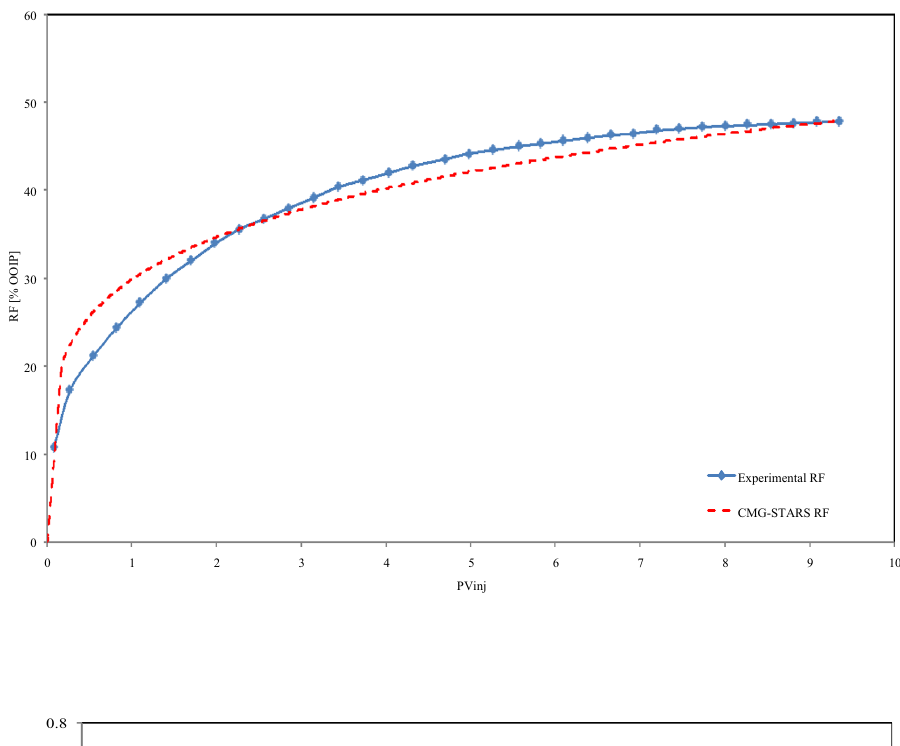
Fig. 12 History matching of the experimental and simulation total production rate for Alka- line (0.7 wt% Na 2 CO 3 )